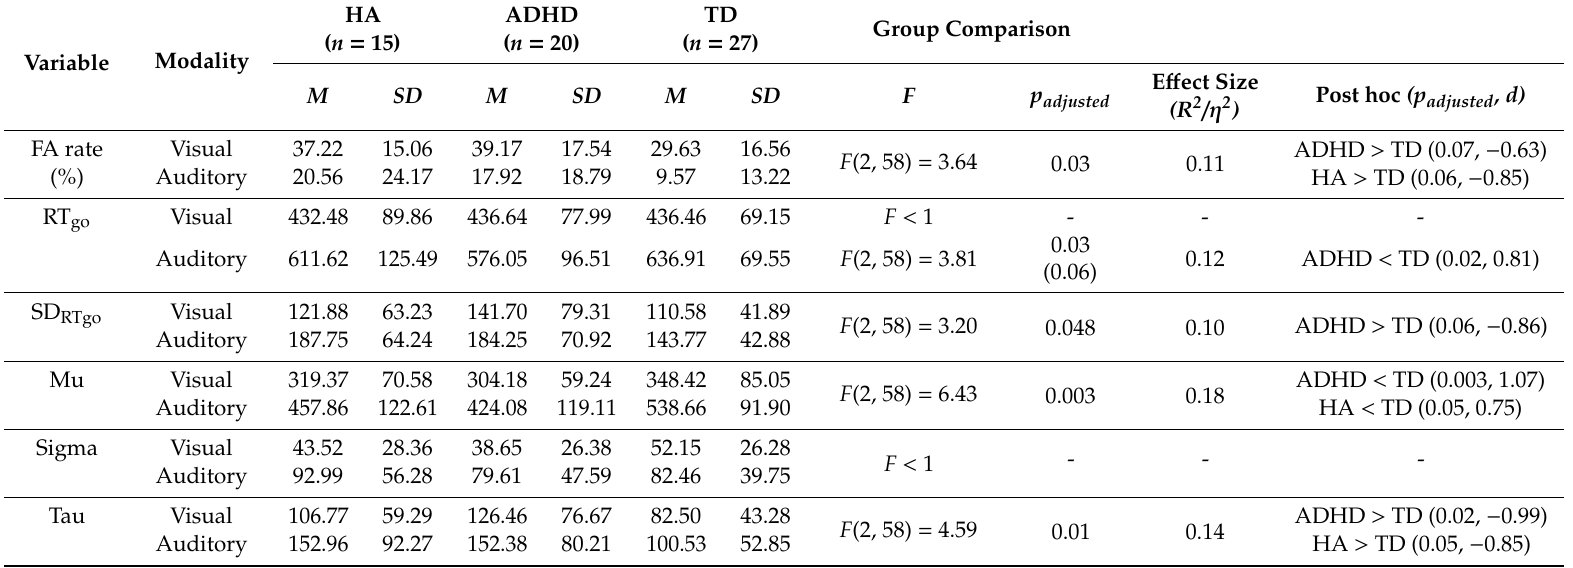
Table 2. Summary of the behavioral performance scores per group and